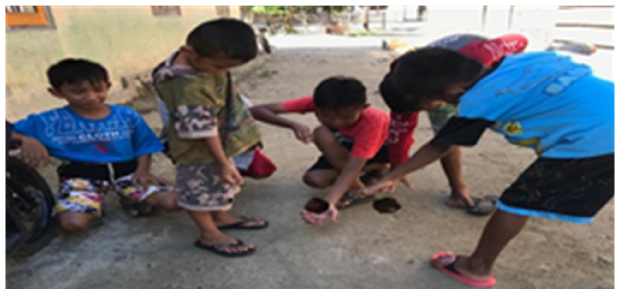
Figure 1. Gasing